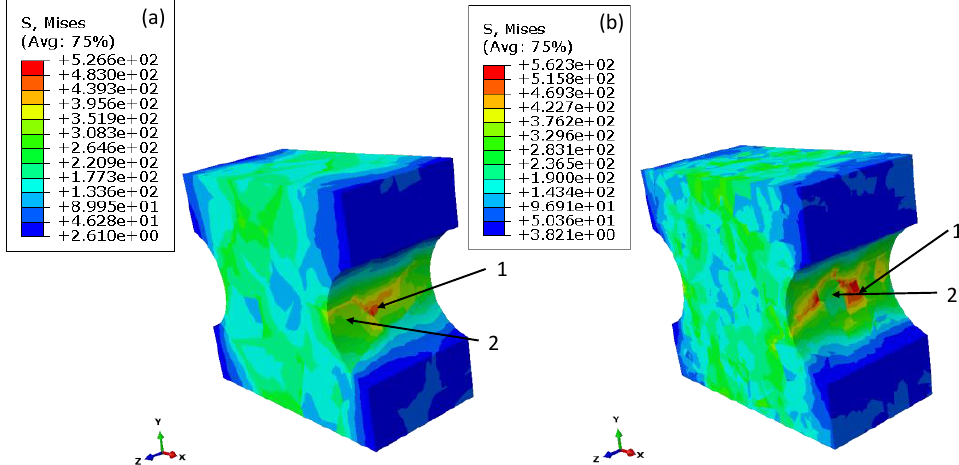
Figure 11. Distribution of von Mises stress for notched specimen for the coarse-grain material (100 grains, ( a )) and fine-grained textured material (1000 grains, ( b )).